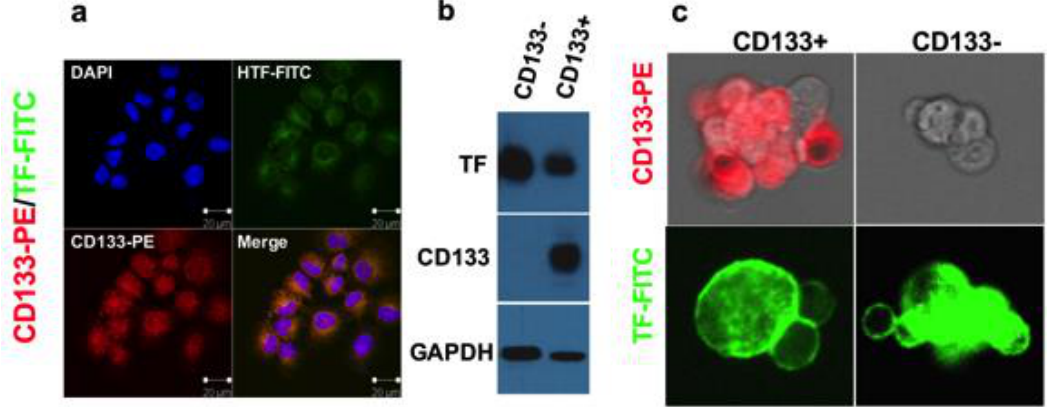
Figure 3. TF is a novel oncotarget in cancer stem cells (CSCs) isolated from in vitro cultured human lung cancer H460 cell line ( a ), human triple-negative breast cancer MDA-MB-231 line ( b ) and from patients’ breast tumor tissues ( c ). ( a ) CD133+ CSCs from H460 lung cancer cell line was immunofluorescently stained for expression of CD133 (red) and TF (green). Their nuclei were stained by DAPI (blue) and the cells were photographed under confocal microscopy (Zeiss). Scale bar: 20 μm. ( b ) Immunoblotting for TF expression on CD133+ CSCs and CD133- non-CSC MDA-MB-231 cells. CD133 expression was confirmed on CD133+ CSCs and GAPDH was used for assessing sample loading. ( c ) Representative imaging of TF expression on breast cancer patients’ CD133+ CSCs and CD133-non-CSCs, CD133 expression was confirmed on CD133+ CSCs (Original magnification: 25 μm under ZEO Fluorescent Cell Imager, Bio-Rad, Hercules, CA, USA). Modified from ref. [16].